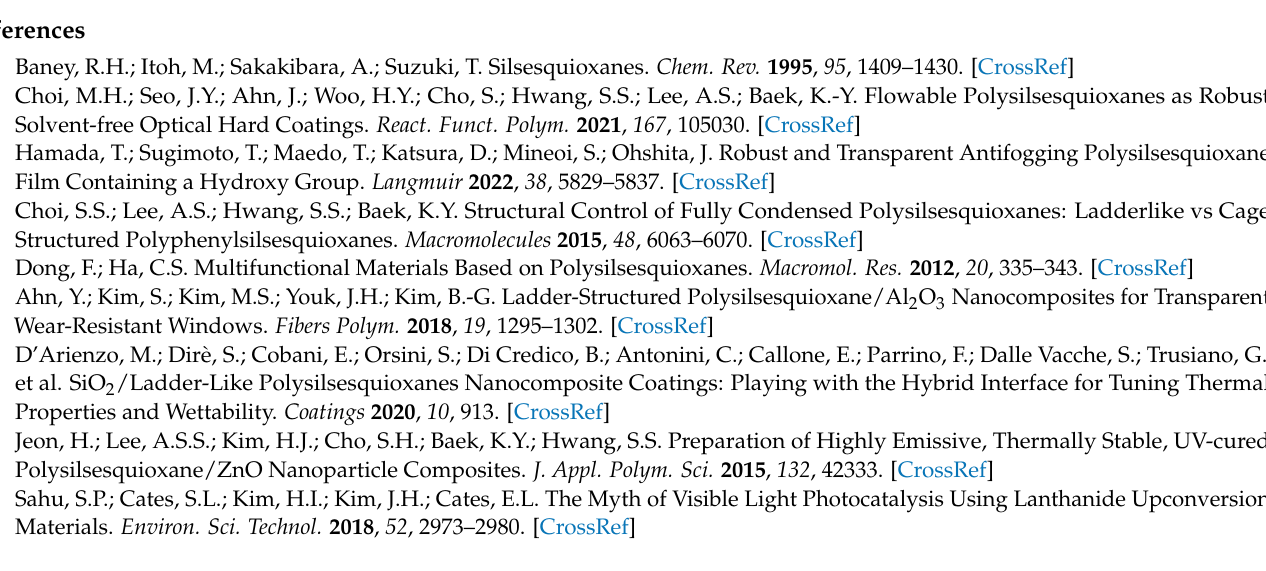
Figure S2: PL spectra of (a) LPGSQ64-Eu, (b) LPGSQ64-Tb, (c) LPGSQ64-Eu:Tb (1:3), and (d)